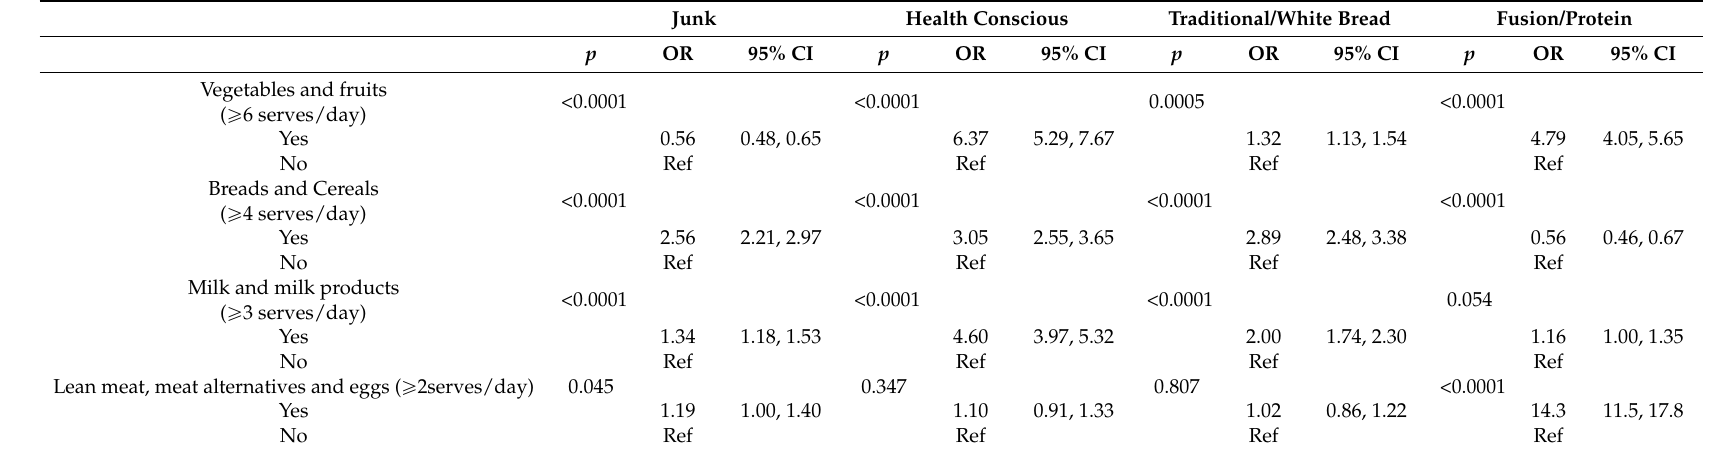
Table 3. Association of each maternal dietary pattern with adherence to dietary guideline recommendations for number of daily servings from each of the four main food groups, adjusting for all maternal socio-demographic, health and lifestyle factors 1 (Odds ratios (OR) and 95% confidence intervals (CI)). Junk